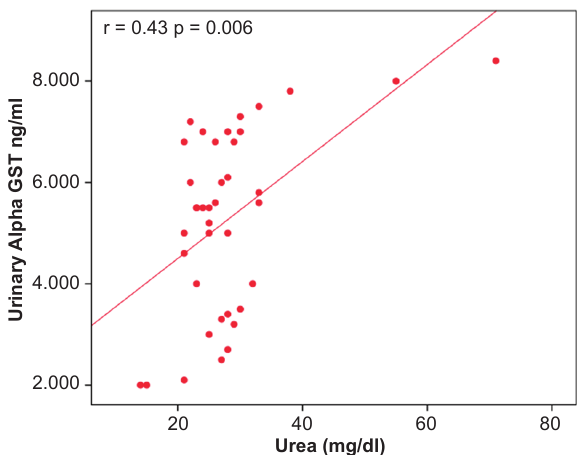
Figure 4: Correlation between urinary alpha glutathione S-transferase and blood urea nitrogen.